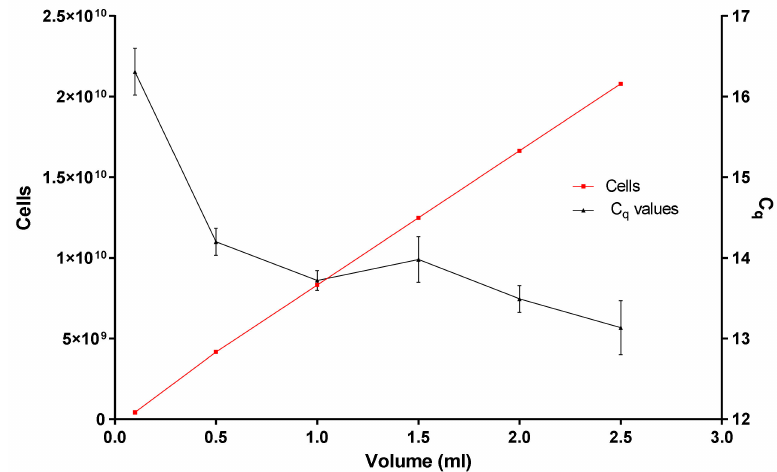
Figure 5. Illustrating the loading and binding capacity of the in-house DNA extraction